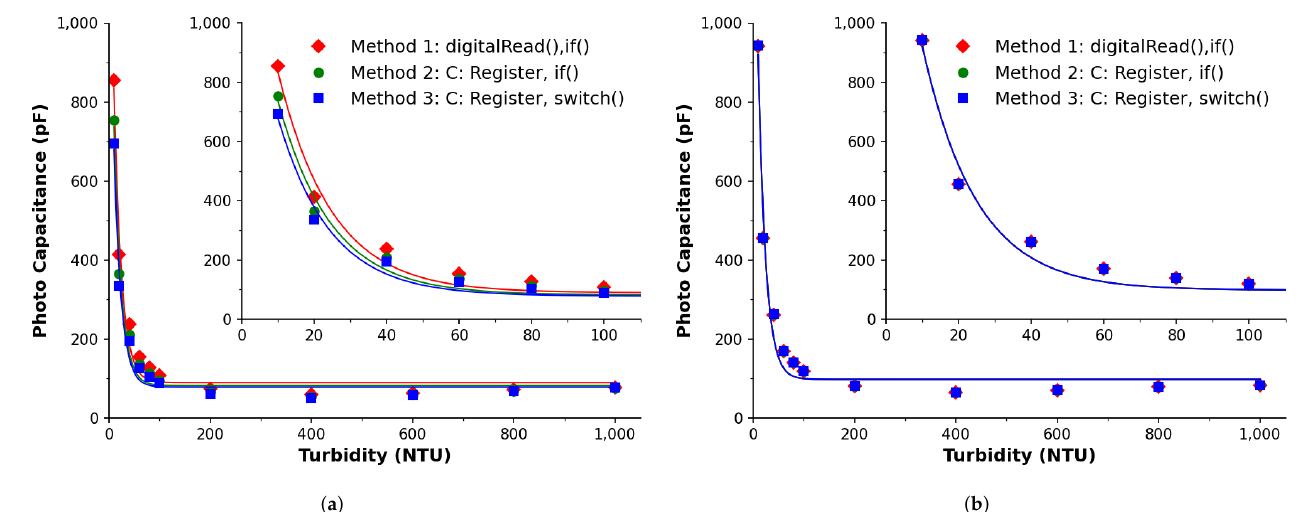
Figure 6. Photo-capacitance discharge profiles derived for each applied method for: the literature derived approach ( a ) and proposed approach ( b ). Method 1 ( (cid:7) ), Method 2 ( implementations of the parameters listed previously in Table 2. ( a ) Photo-capacitance: uncorrected T s . ( b ) Photo-capacitance: corrected T s